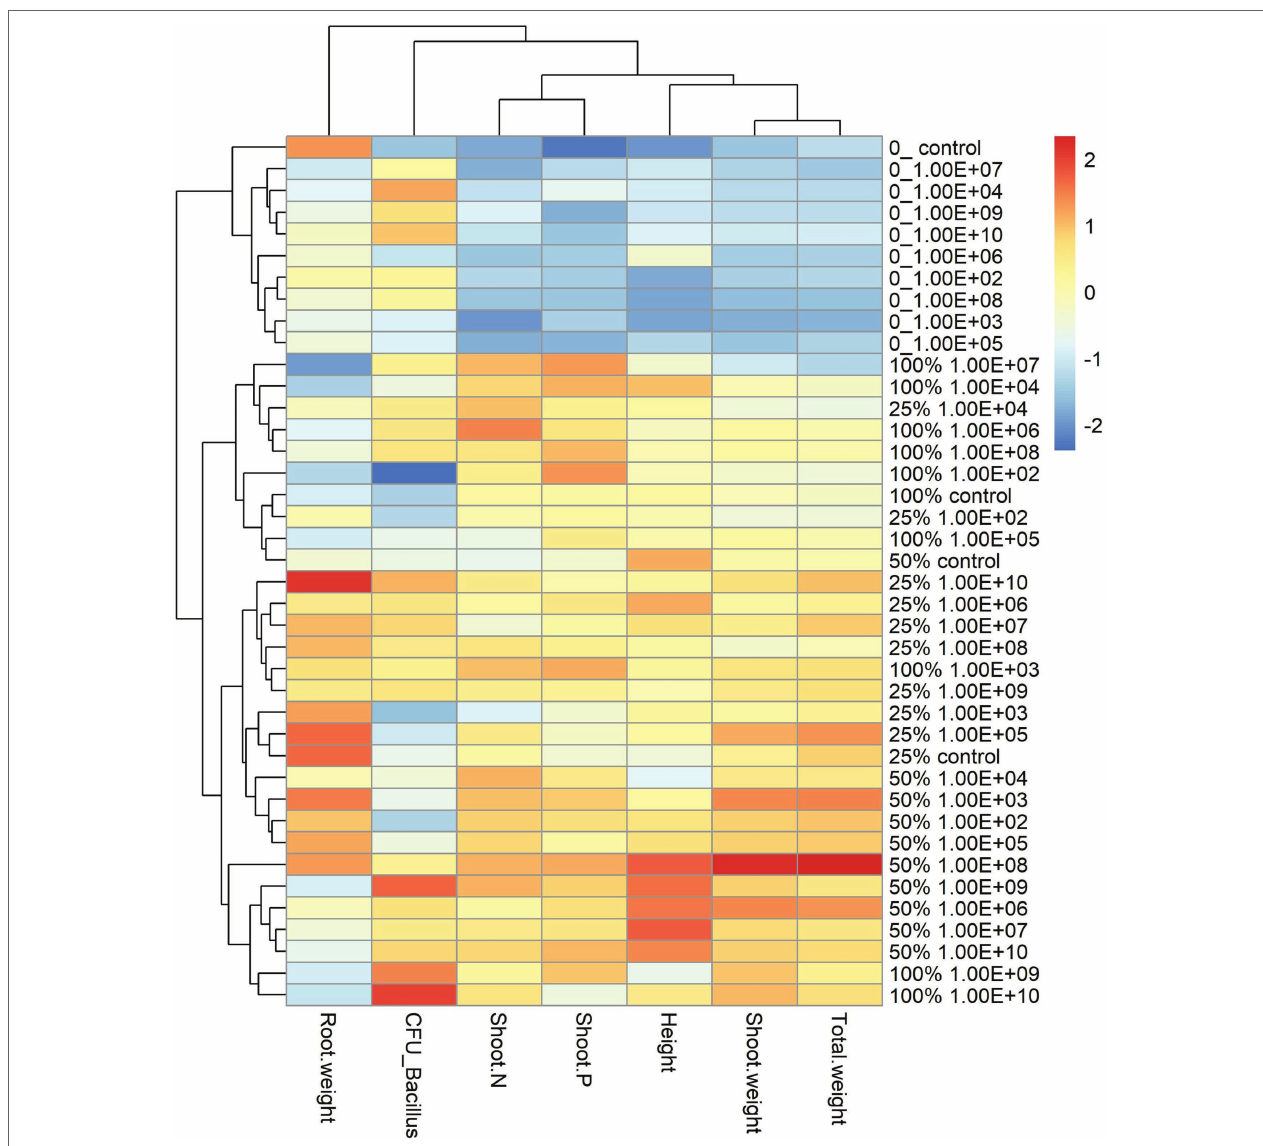
FIGURE 5 | Heatmap with cluster analysis. The column corresponds to inoculation concentrations and mineral fertilization doses and the line to the biometric parameters of the maize plant. The Y axis—0_ indicates the fertilization dose, and 1.00E+02 indicates the inoculum concentration. The fertilization doses were 0%, 25%, 50% and 100%, and the fertilization doses were 1 × 10 2 CFU ml − 1 , 1 × 10 3 CFU ml − 1 , 1 × 10 4 CFU ml − 1 , 1 × 10 5 CFU ml − 1 , 1 × 10 6 CFU ml − 1 , 1 × 10 7 CFU ml − 1 , 1 × 10 8 CFU ml − 1 , 1 × 10 9 CFU ml − 1 , and 1 × 10 10 CFU ml − 1 , representing 1.00E+02, 1.00E+03, 1.00E+04, 1.00E+05, 1.00E+06, 1.00E+07, 1.00E+08, 1.00E+09, and 1.00E+10, respectively. The X-axis indicates the parameters of plant growth—total weight (g); shoot weight (g); height (cm); shoot P—phosphorus content in shoot g kg − 1 ; shoot N—nitrogen content in shoot g kg − 1 ; CFU_ Bacillus—amount of Bacillus reisolated from root CFU g − 1 and root weight